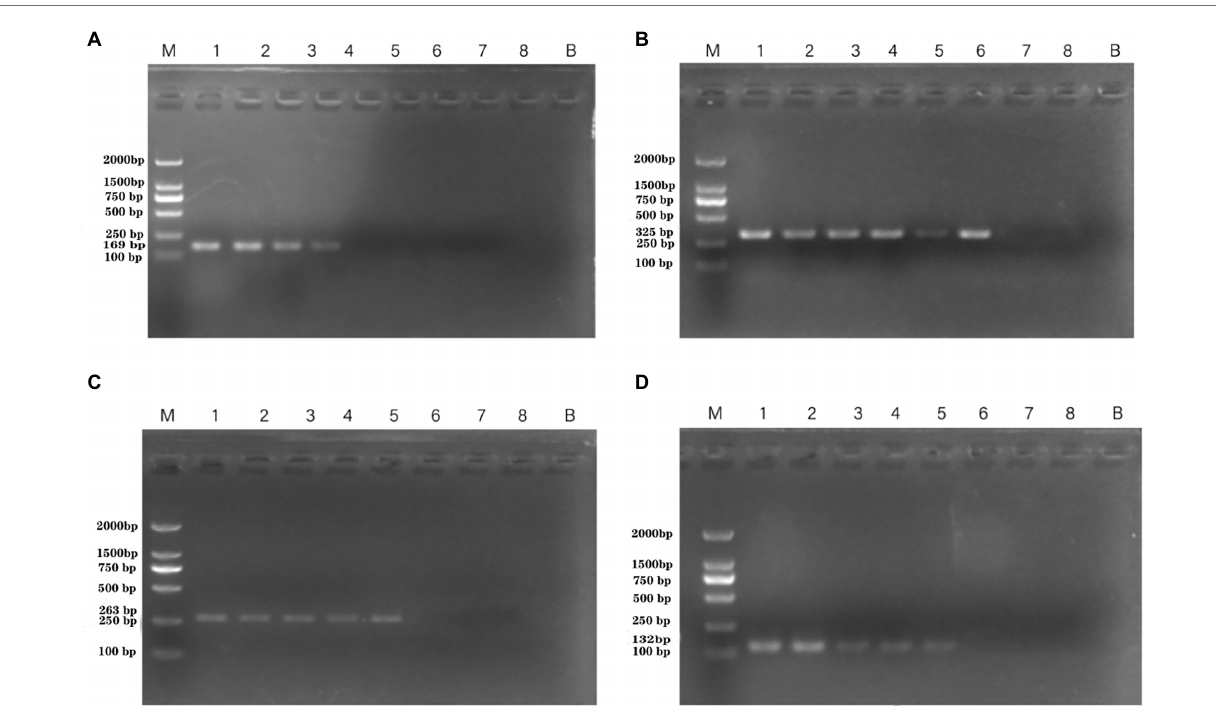
FIGURE 3 | PCR detection sensitivity using dilutions of a pure culture of P. aeruginosa ATCC 15442. Lane M = DSTM 2000 marker (Dongsheng Biotechnology, Guangdong, China); lane N = negative control (double-distilled H 2 O); and lanes 1–8 = 2.07 × 10 8 CFU/ml, 2.07 × 10 7 CFU/ml, 1.85 × 10 6 CFU/ml, 4.15 × 10 5 CFU/ml, 4.3 × 10 4 CFU/ml, 9.7 × 10 3 CFU/ml, 1.4 × 10 2 CFU/ml, and 2 × 10 1 CFU/ml, respectively. (A) Primer set PA1 (169 bp); (B) primer set PA2 (325 bp); (C) primer set PA3 (263 bp); and (D) primer set PA4 (132 bp).